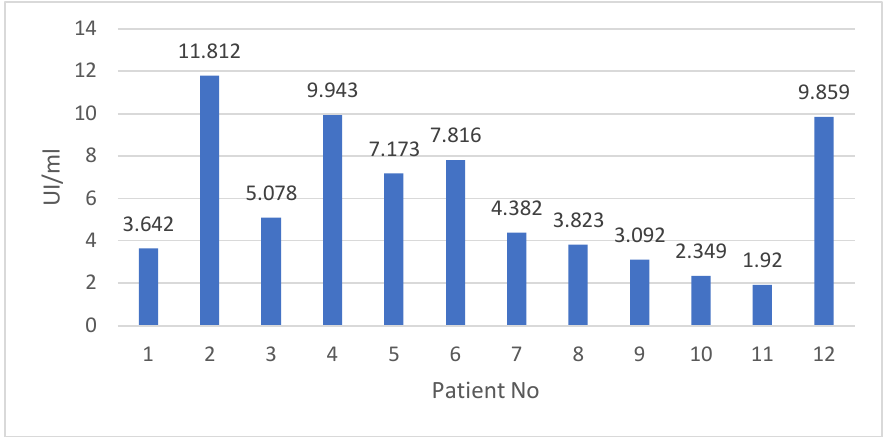
Figure 1. Quantitative determination of IgG anti-HEV antibodies of group B patients.